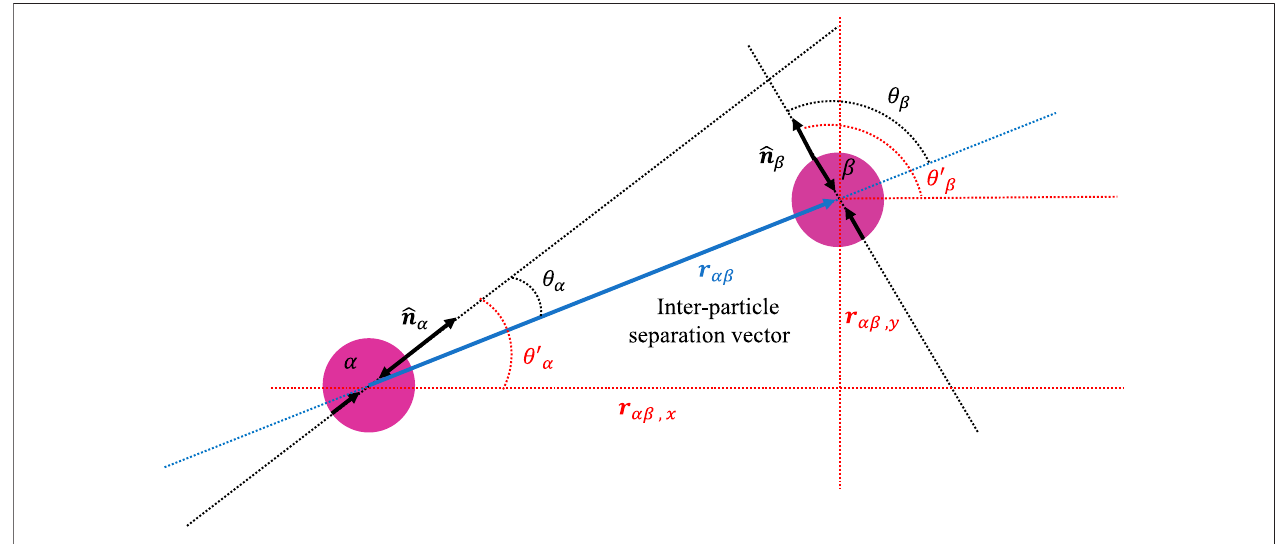
FIGURE10| Schematicoftwointeractingparticleswithallrelevantanglesandvectorslabeled. ^ n i areunitvectorsofforcedipoles. θ i ′ areanglesofforcedipoleswith respect to the lab frame x -axis. θ α and θ β are angles of force dipoles with respect to their separation vector r αβ which has components r αβ , x and r αβ , y .